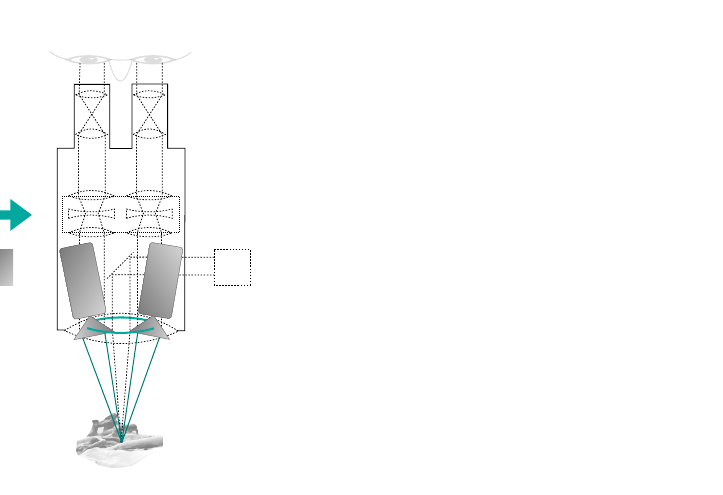
Figure 4. Simplifications used in our surgical microscope model. The optical setup within the microscope is omitted and the main objective lens is assumed to be ideal. The cameras are placed directly on the non-refracted ray paths, at a distance from the object equal to the focal length of the main objective lens. The cameras are located on a ring with the diameter of the CMO lens (shown in green).